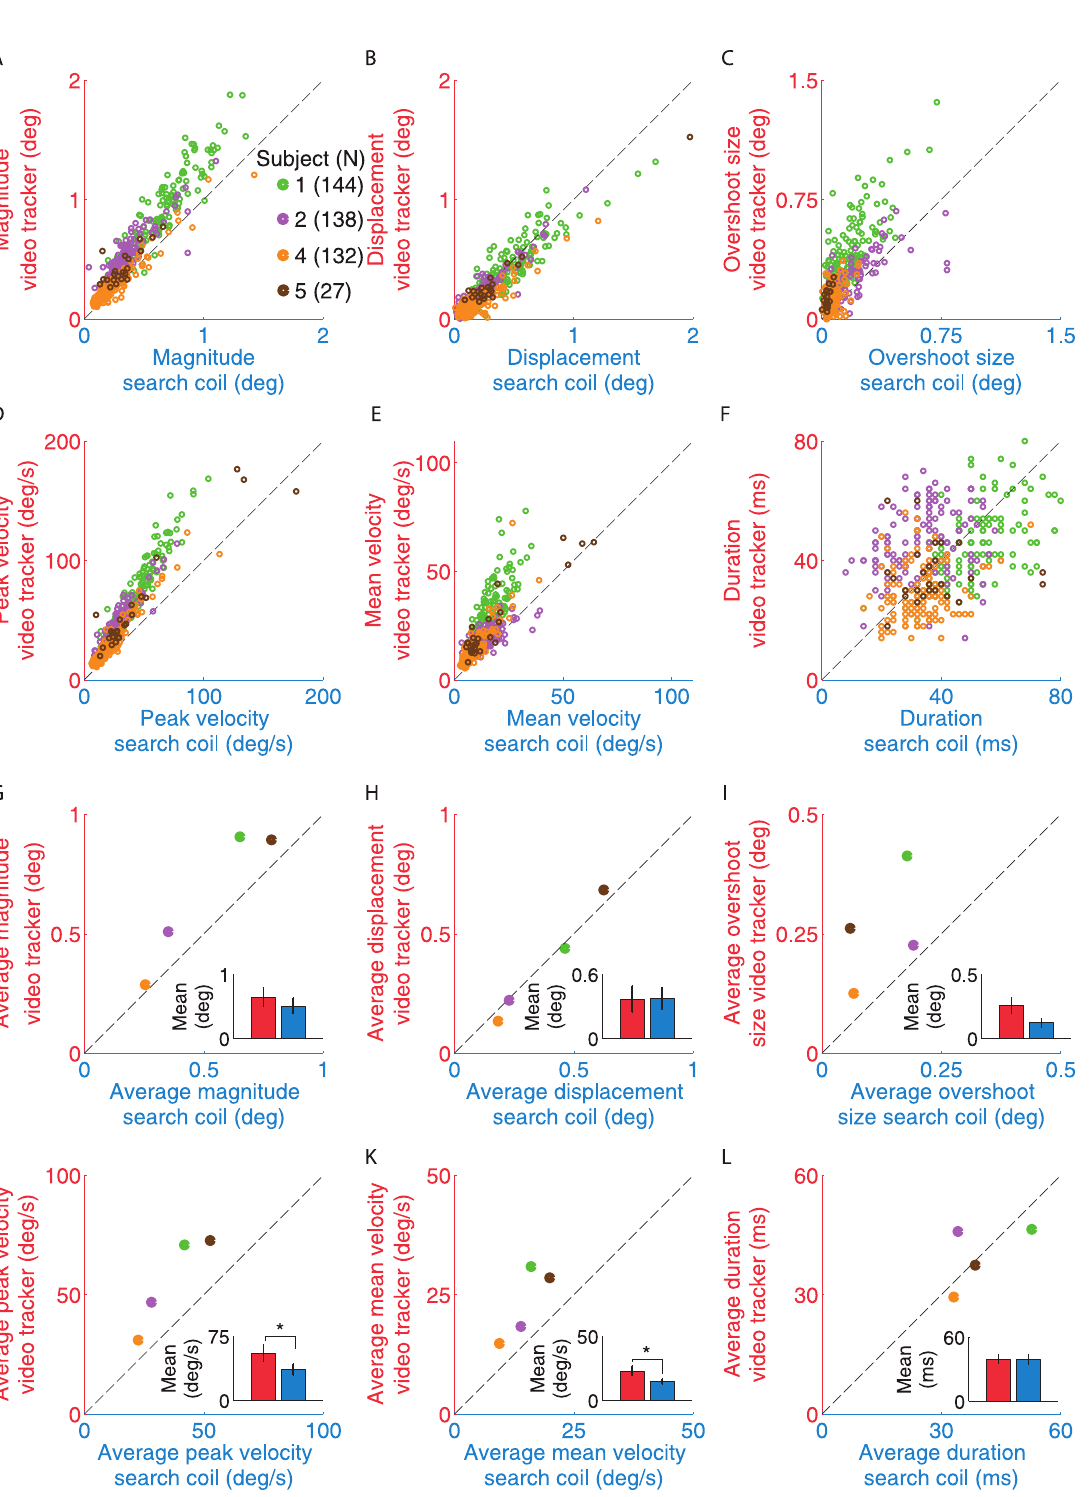
Fig 8. Comparison of microsaccade properties for microsaccades detected in both recording systems. Scatter plots for microsaccade magnitude ( A ), displacement ( B ), overshoot size ( C ), peak velocity ( D ), mean velocity ( E ), and duration ( F ). Each dot in ( A – F ) represents one microsaccade, with the property as measured with the video tracker on the y -axis and with the search coil on the x -axis. Average microsaccade magnitude ( G ), displacement ( H ), overshoot size ( I ), peak velocity ( J ), mean velocity ( K ), and duration ( L ), for each participant (i.e. average data from panels A – F ). Each dot represents the average microsaccade property for one participant as measured with the video tracker on the y -axis and with the search coil on the x -axis. In the legend in